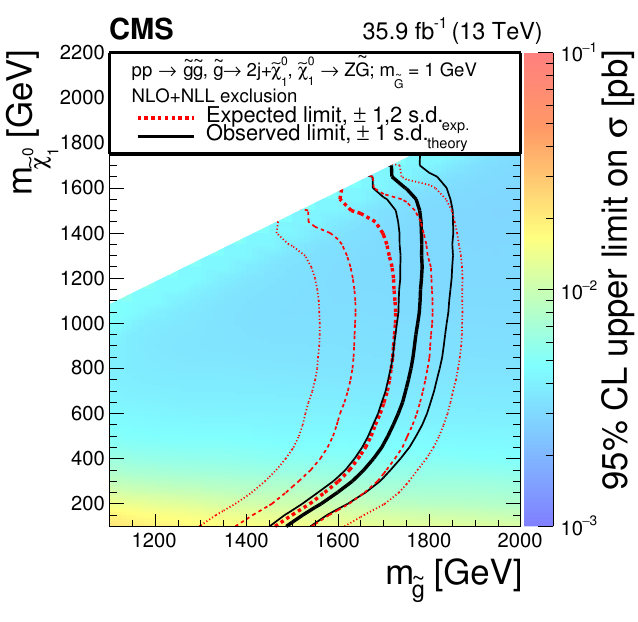
Figure 7 . Cross section upper limit and exclusion contours at 95% CL for the gluino GMSB model as a function of the g and (cid:31) 0 masses, obtained from the results of the strong production 1 on-Z search. The region to the left of the thick red dotted (black solid) line is excluded by the expected (observed) limit. The thin red dotted curves indicate the regions containing 68 and 95% e e of the distribution of limits expected under the background-only hypothesis. The thin solid black curves show the change in the observed limit due to variation of the signal cross sections within their theoretical